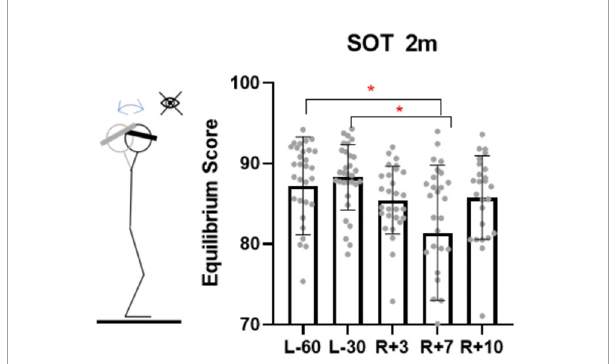
FIGURE6 Sensory organization test with eyes closed, fixed platform and head tilting (proprioceptive testing). L-60 – 60 days before launch, L-30 – 30 days before launch, R + 3 – 3rd day of recovery period after landing, R + 7 – 7th day after landing, R + 10 – 10th day after